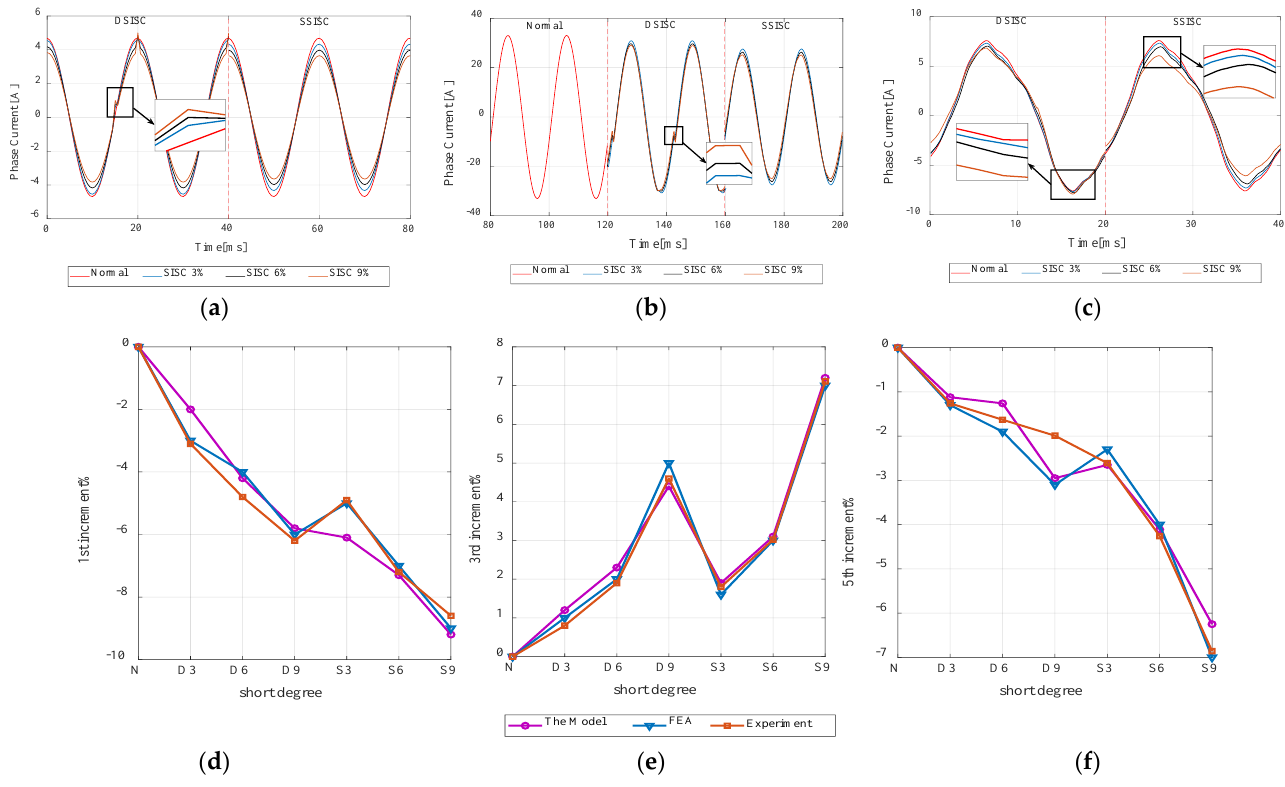
Figure 7. Current in varied DSISC degree cases: ( a – c ) waves by model, FEA and experiment, and